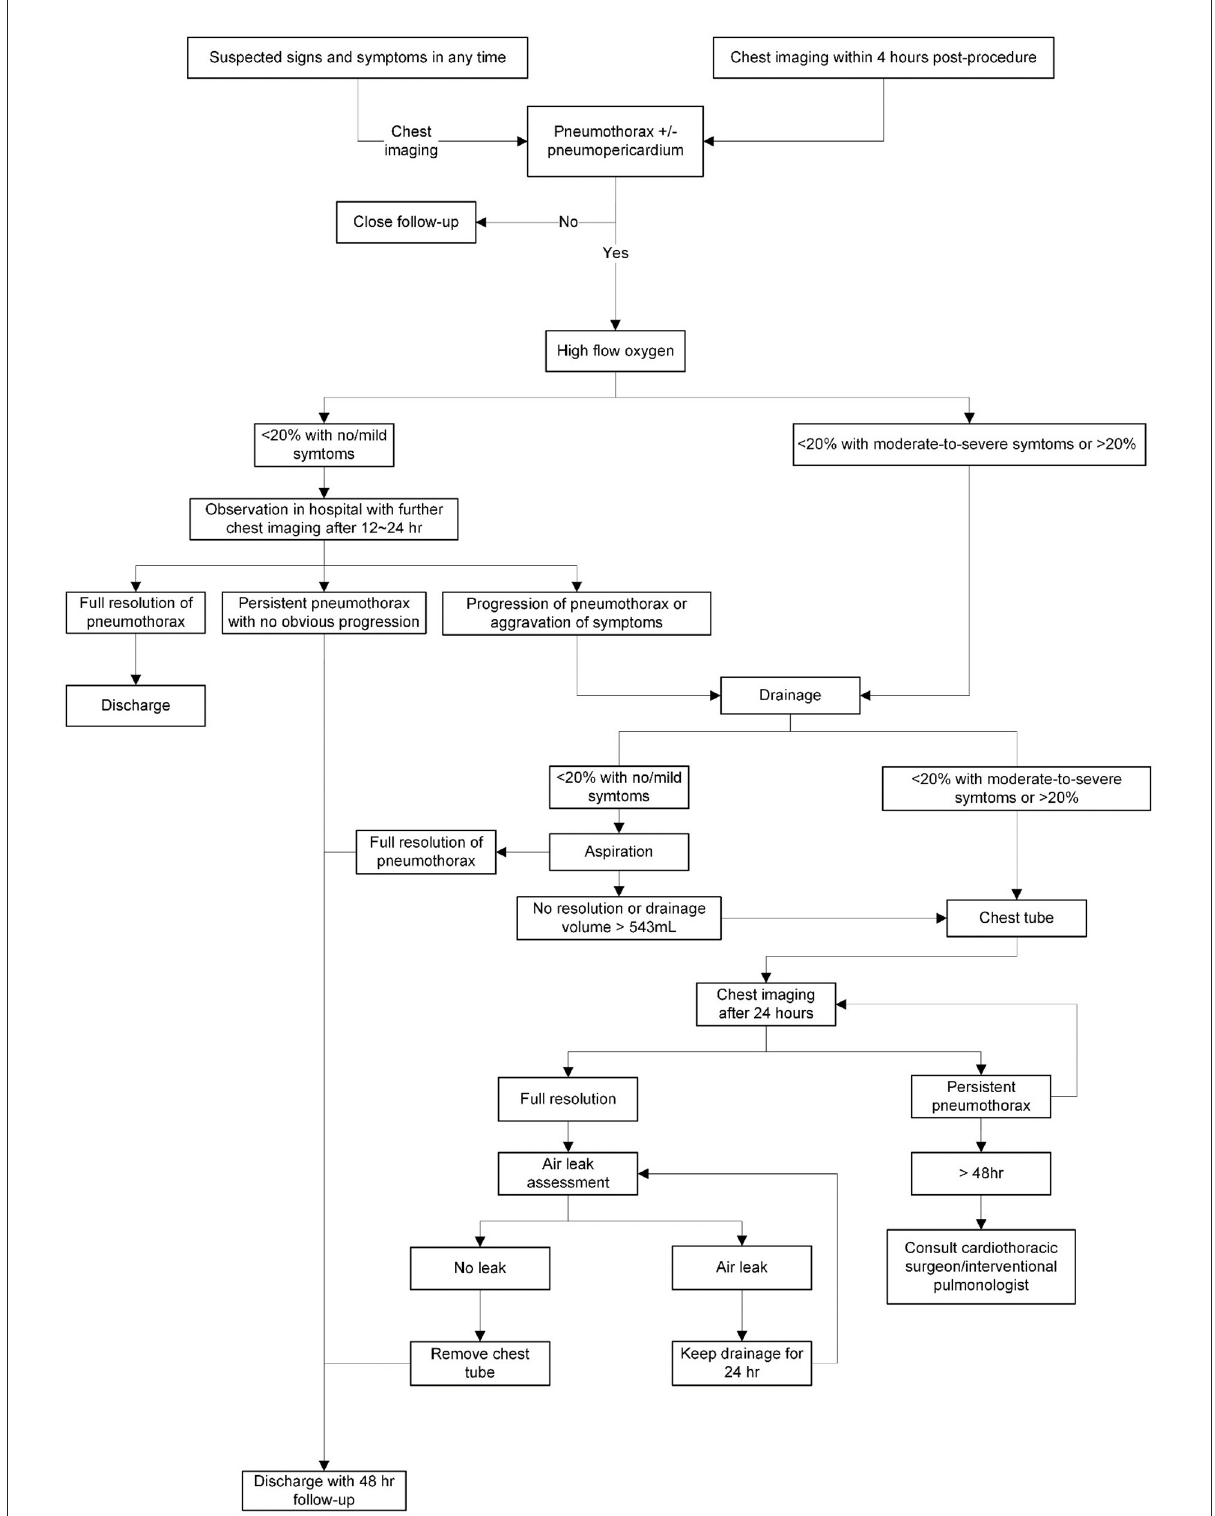
FIGURE3 The management of cardiac implantable electronic device (CIED)-induced pneumothorax and concurrent